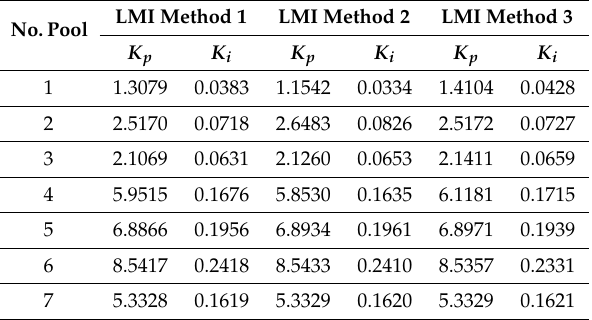
Table 2. Proportional and Integral parameters of proportional-integral (PI) controllers based on the linear matrix inequality (LMI)